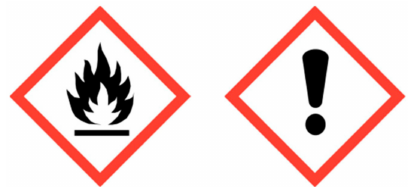
Figure 4. Hazard communication pictograms for bioethanol ( left fire risk, right health